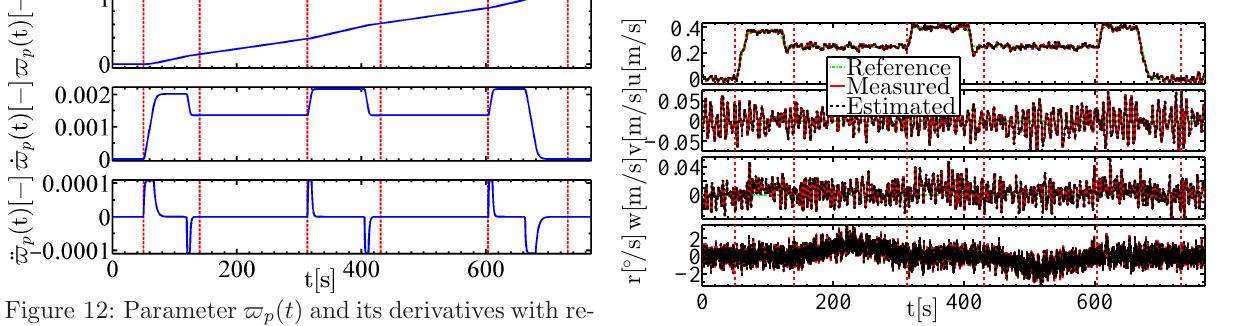
Figure 16: Linear and angular velocities (BF frame).